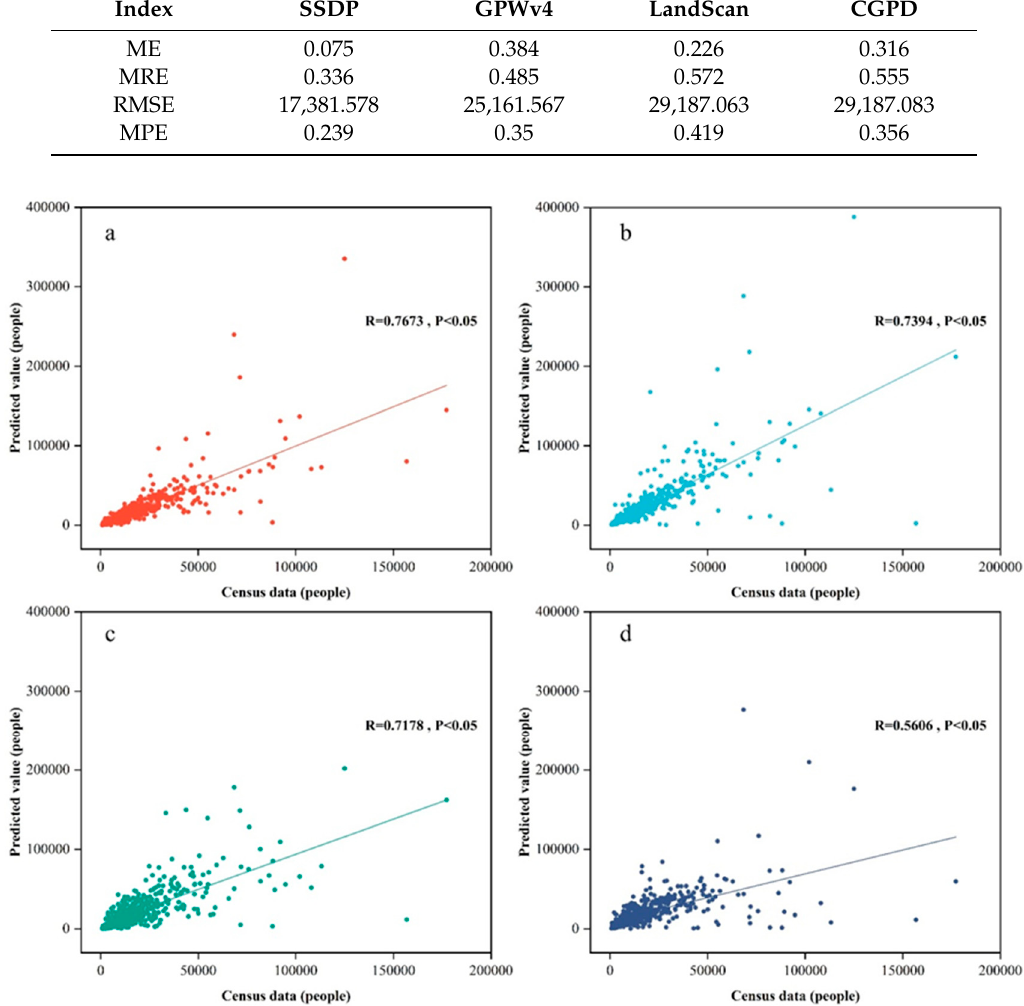
Figure 6. Comparison of the correlations between predicted populations with census data in 500 selected towns: ( a ) spatial distribution of the population (SSDP), ( b ) Gridded Population of the World (GPW)v4, ( c ) LandScan, and ( d ) China Gridded Population Datasets (CGPD).